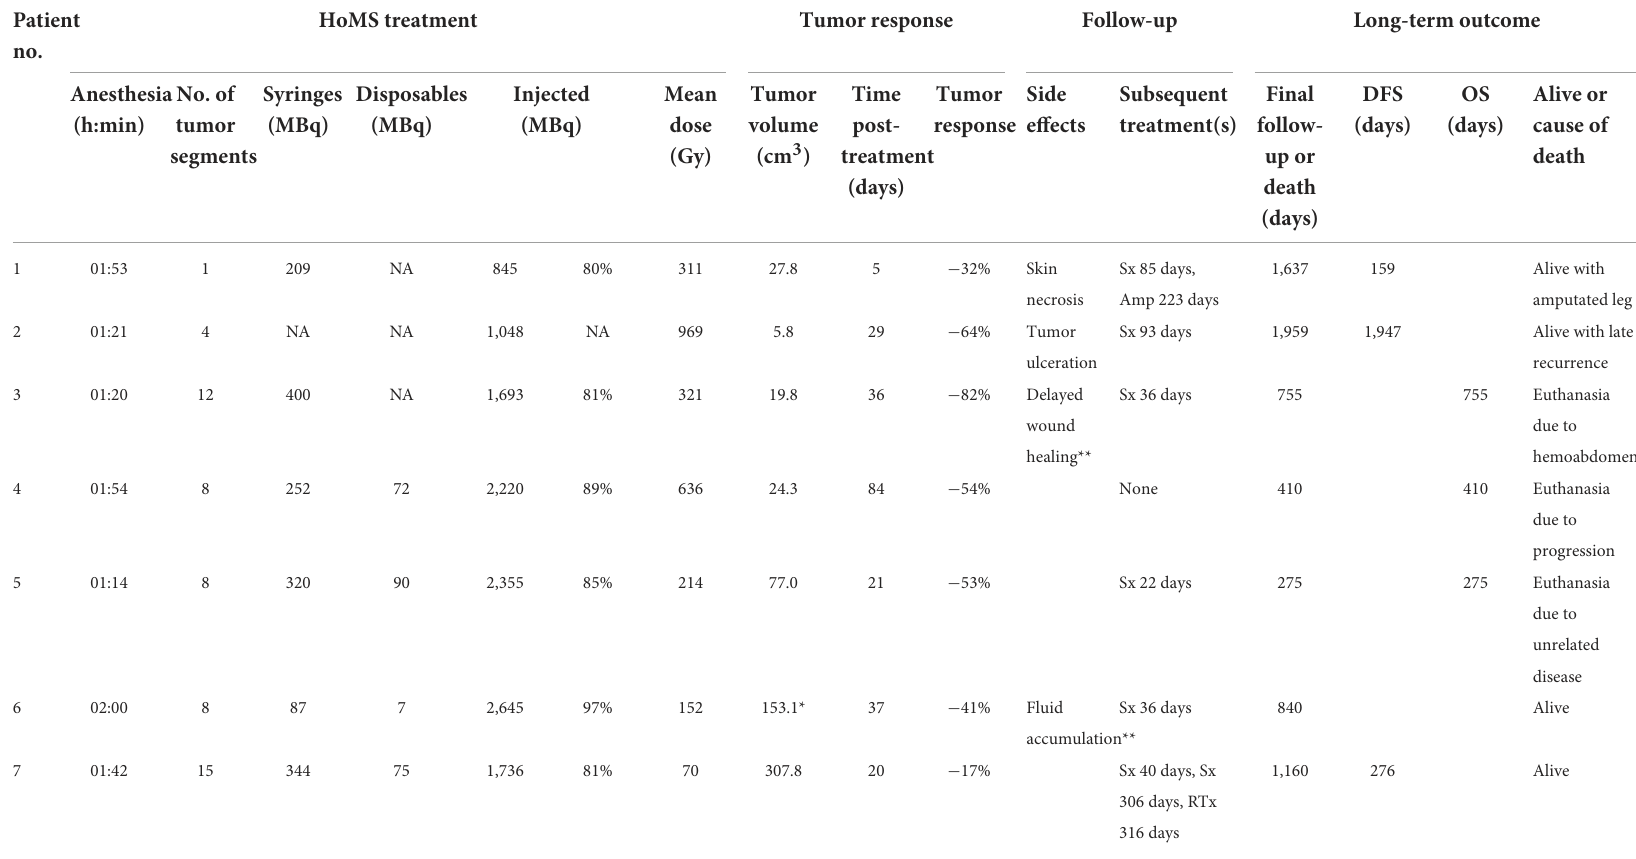
TABLE 2 Results of holmium-166 microbrachytherapy of seven canine patients with soft tissue